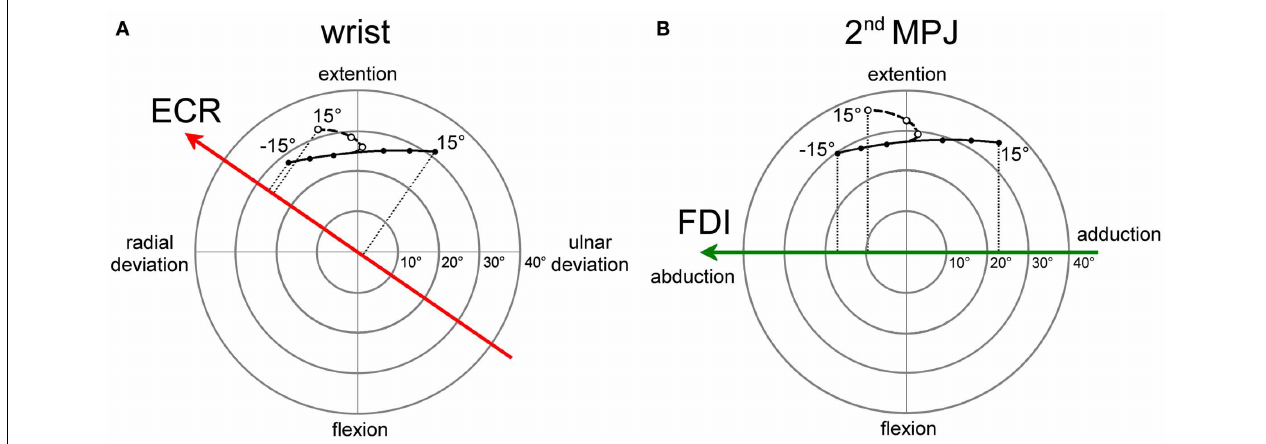
FIGURE 8 | Polar plot representations of the angular motion of wrist (A) and 2nd metacarpo-phalangeal (B) joints that were utilized for computing model predictions. Bold vectors represent the pulling directions of the ECR (red) and FDI (green) muscles in the respective joint angular space. The ECR (A) and FDI (B) muscles are activated in a single-joint pointing movement by an amount proportional to the orthogonal projection of